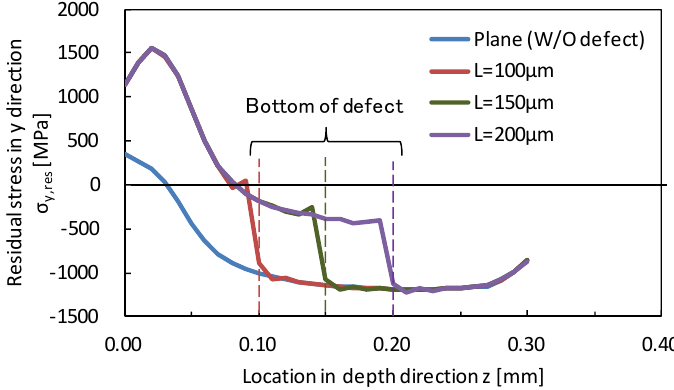
Figure 6: Residual stress distributions along defect obtained from elastic–plastic FE